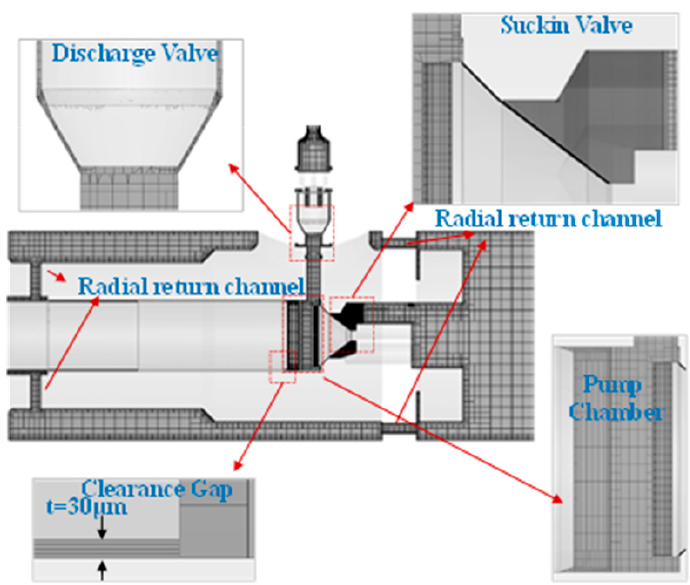
Figure 3. High-pressure liquid hydrogen pump structure mesh division.